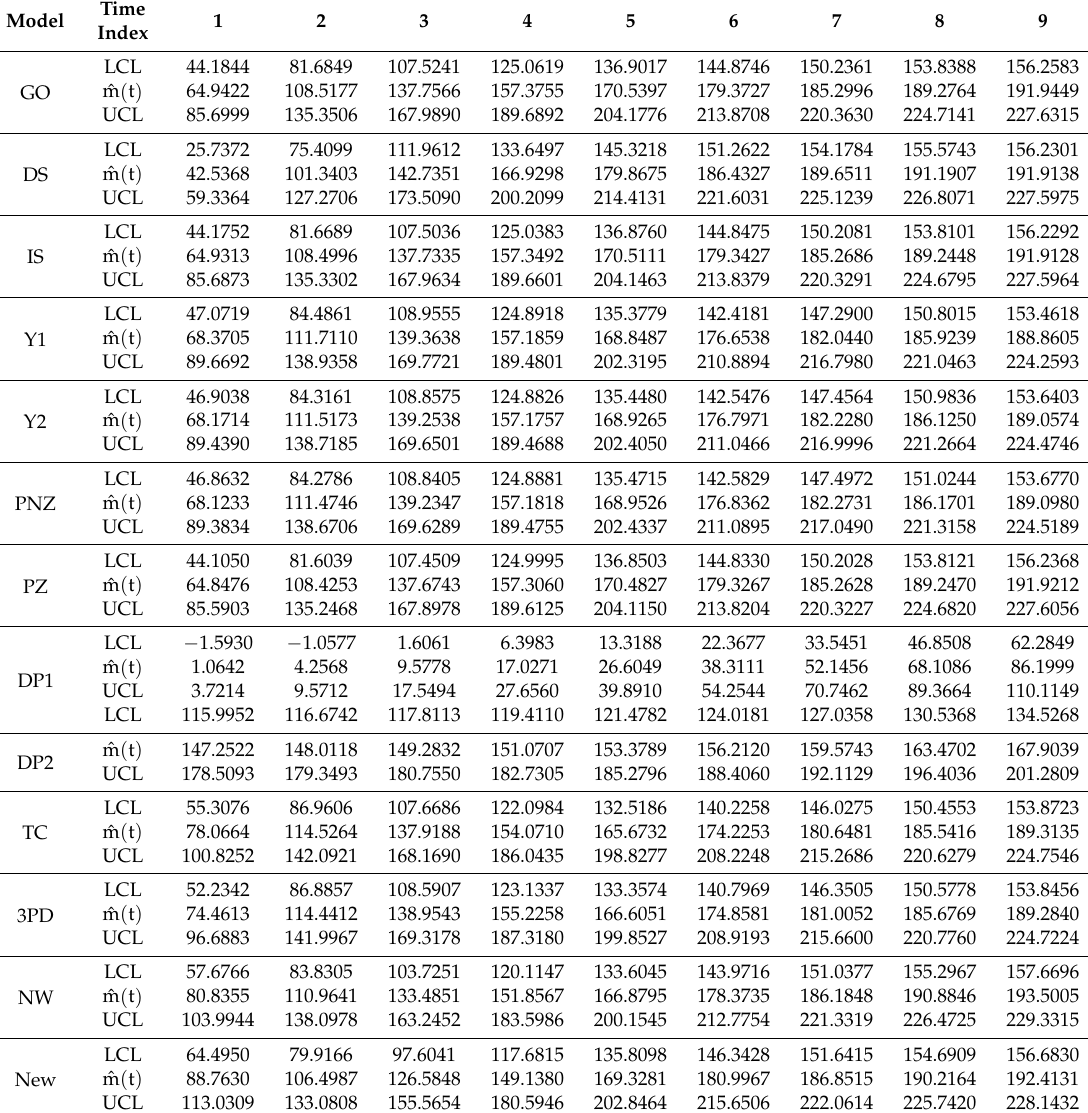
Table A2. 99% Confidence interval of all 13 NHPP SRMs from Dataset